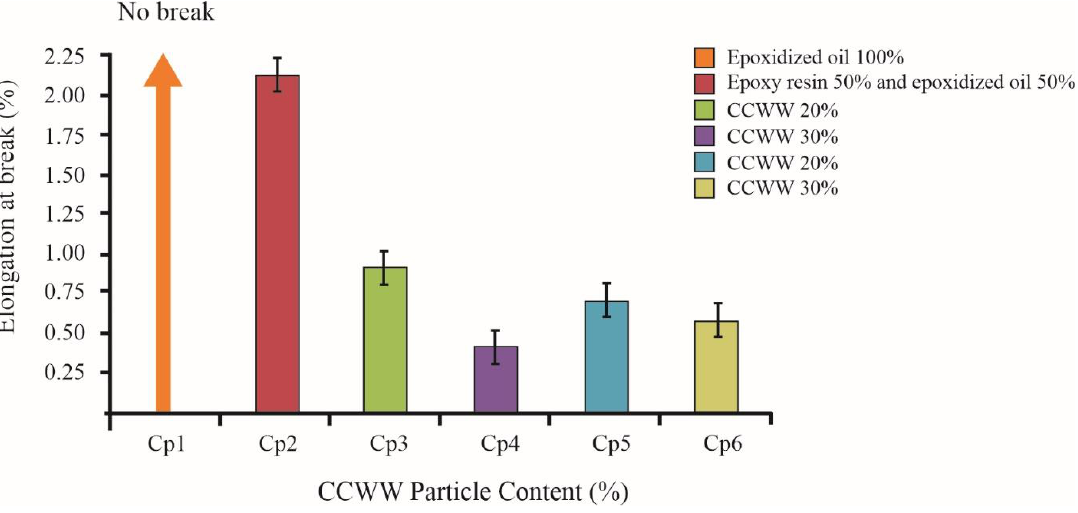
Figure 6. Elongation at break for the cured neat resins and for the produced particleboards.